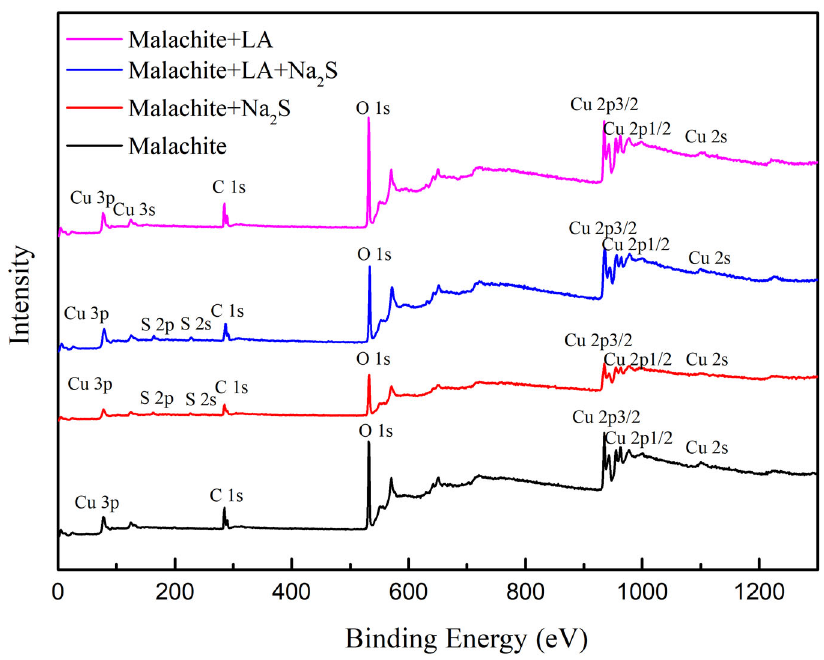
Figure 9. Figure 9. XPS spectra of malachite before or after treatment ( c (LA) = 6.0 × 10 − 5 mol/L; c (Na 2 S) = 3.0 × 10 − 3 mol/L; pH = 9.6). Table 2. Relative contents of representative elemental constituents of malachite